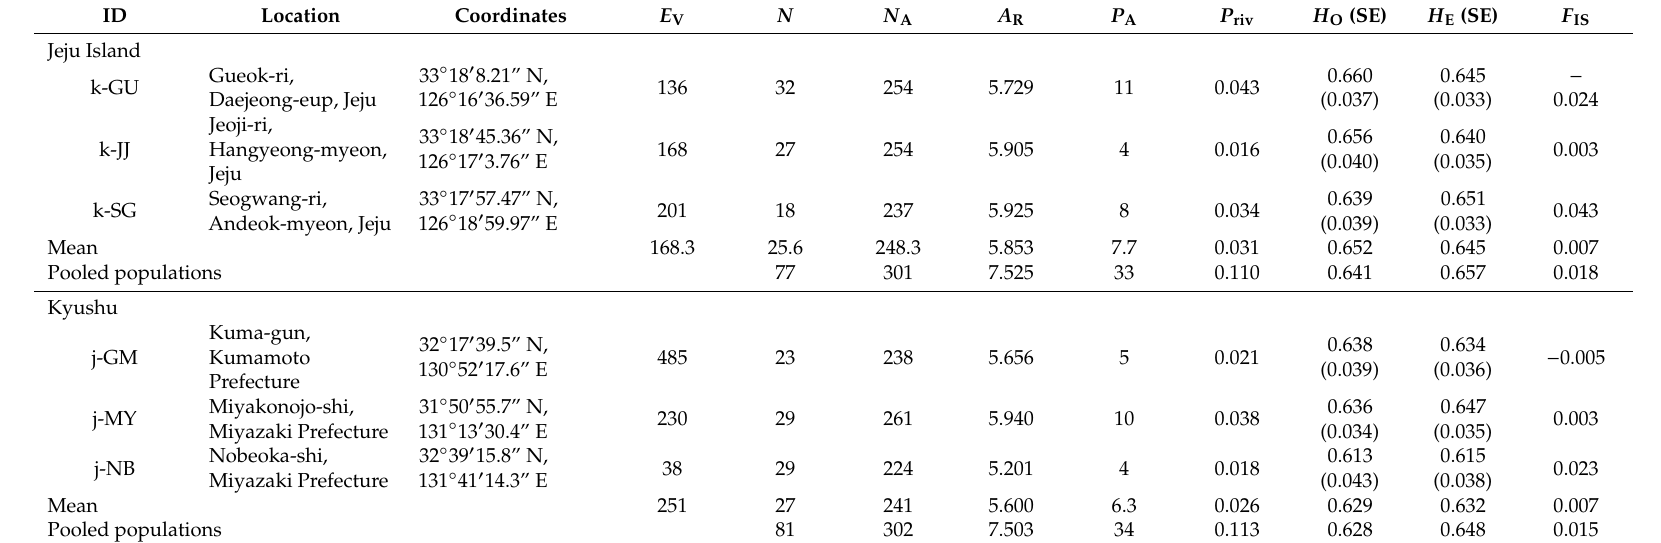
Table 3. Summary statistics of genetic diversity for six populations based on 40 microsatellite loci of Quercus